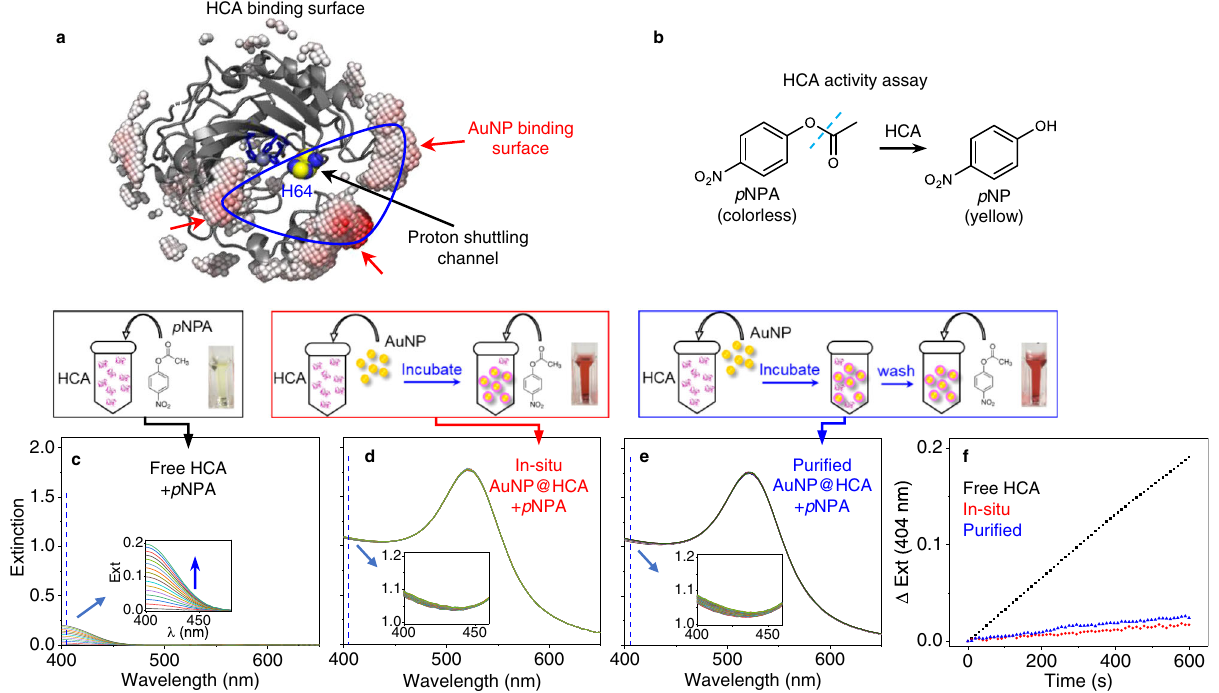
Fig.5|PredictionofboundorientationofHumancarbonicanhydrase(HCA)on AuNP. a Cartoon structure of HCA showing the predicted AuNP-binding surface (highlighted blue region) with virtual atoms, with respect to its active center (highlighted in blue sticks), proton shuttling channel, Zn 2+ (gray sphere) and H64 (highlighted blue and yellow spheres). b Mechanism of HCA assay of hydrolyzing colorless p NPA to yellow p NP, which absorbs at 404nm. c – e Time-resolved UV-vis spectra of HCA assay solutions with incubation time of 10min using free HCA